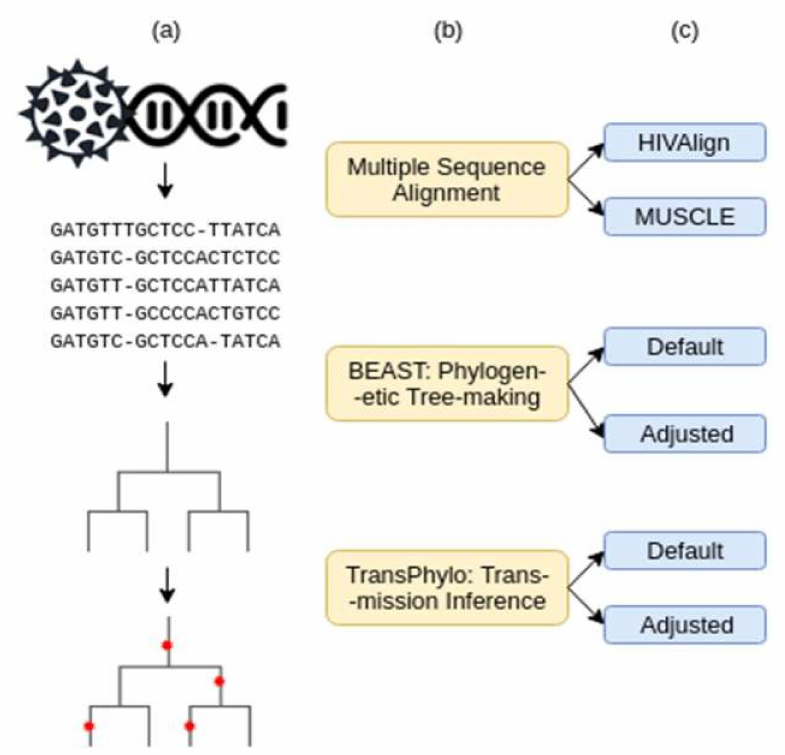
Figure 1. Workflow of data analysis procedures. ( a ) Graphic representation of the data input / output. ( b ) Pipeline tools and how they were used. ( c ) Parameters tested for each